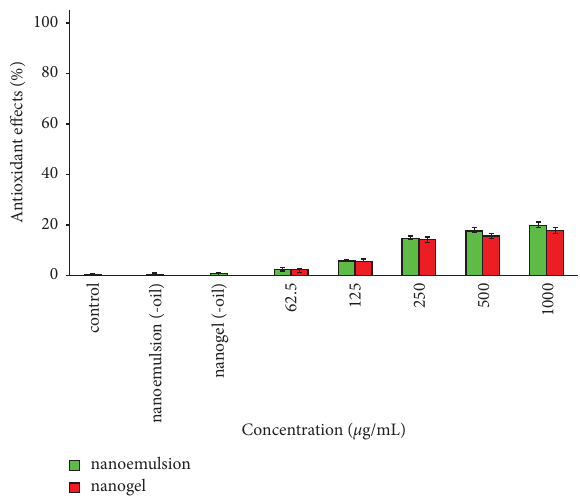
Figure 4: Antioxidant efects of the nanoemulsion and nanogel containing C . cyminum